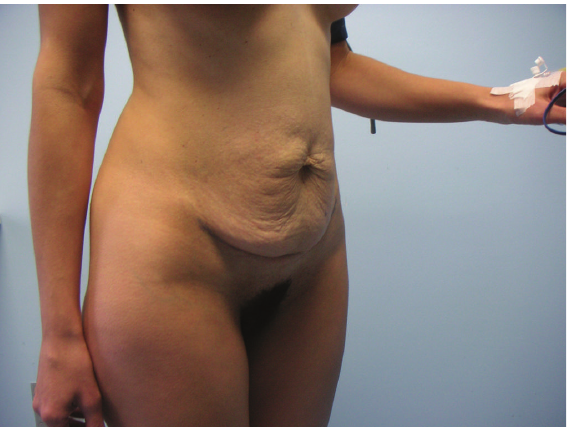
Figure 2: Lateral view of a 30-year-old female patient with Cutis laxa before